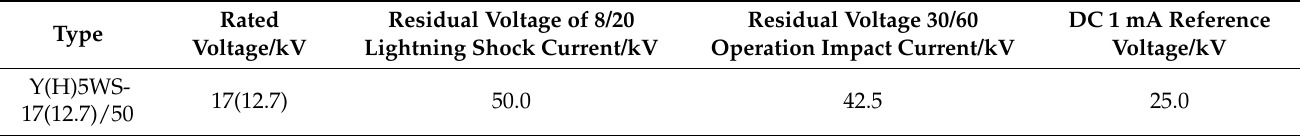
Table 1. The basic electrical characteristics of MOV.